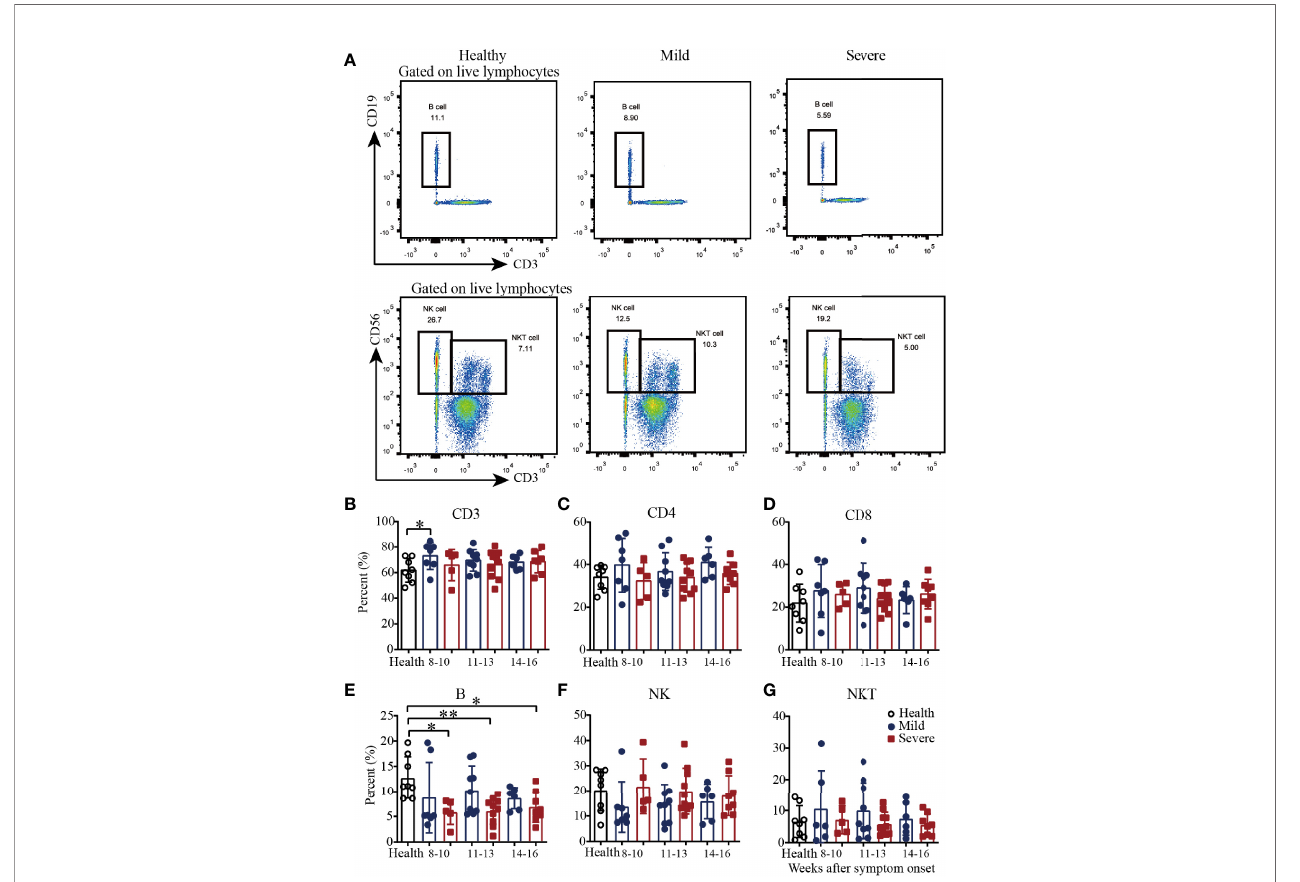
FIGURE 1 | Phenotypic analysis of PBMCs from recovered COVID-19 patients. Representative fl ow cytometry plots showing the expression patterns of different immune cell subsets in recovered COVID-19 patients (A) . Comparison of the frequencies of CD3 + (B) , CD4 + (C) , CD8 + (D) , B cells (E) , NK cells (F) and NKT cells (G) between mild and severe patients from 8 to 16 weeks after symptom onset (Health, n=8; patient, n=22). *P<0.05;